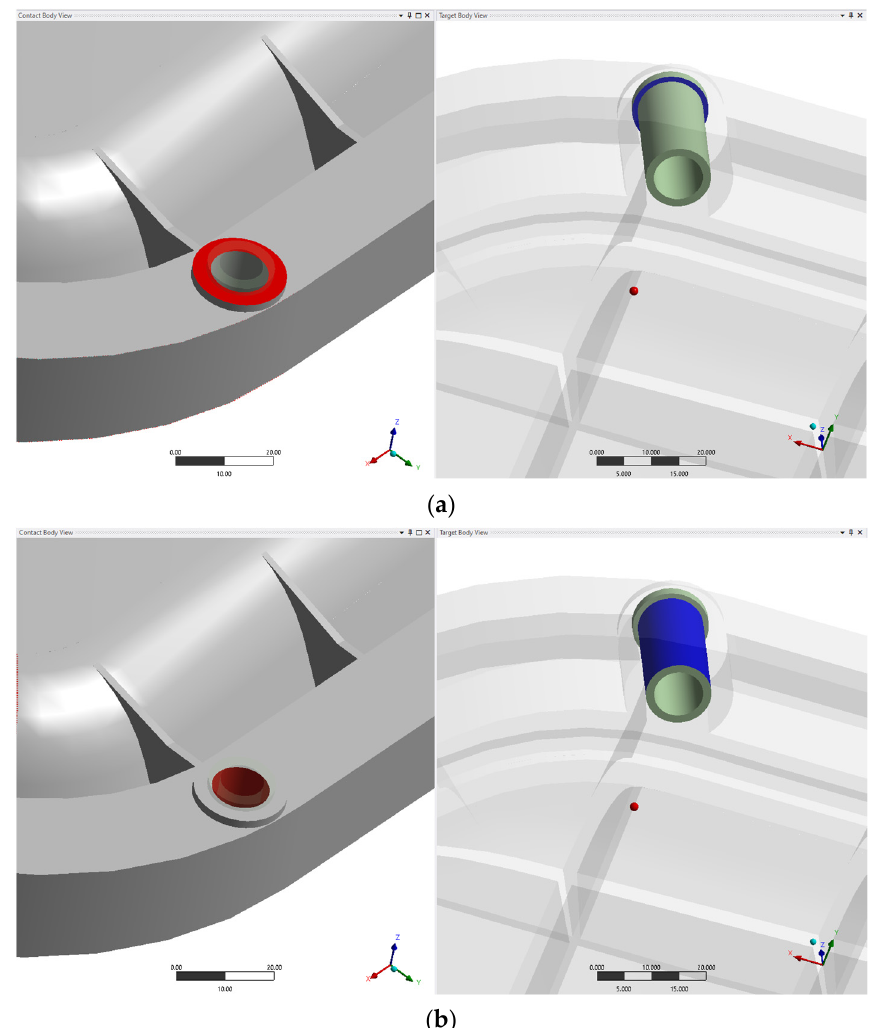
Figure 4. ( a ) Bonded contact condition; ( b ) Frictionless contact condition.